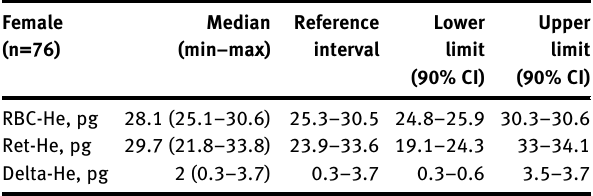
Table  : Reference intervals for